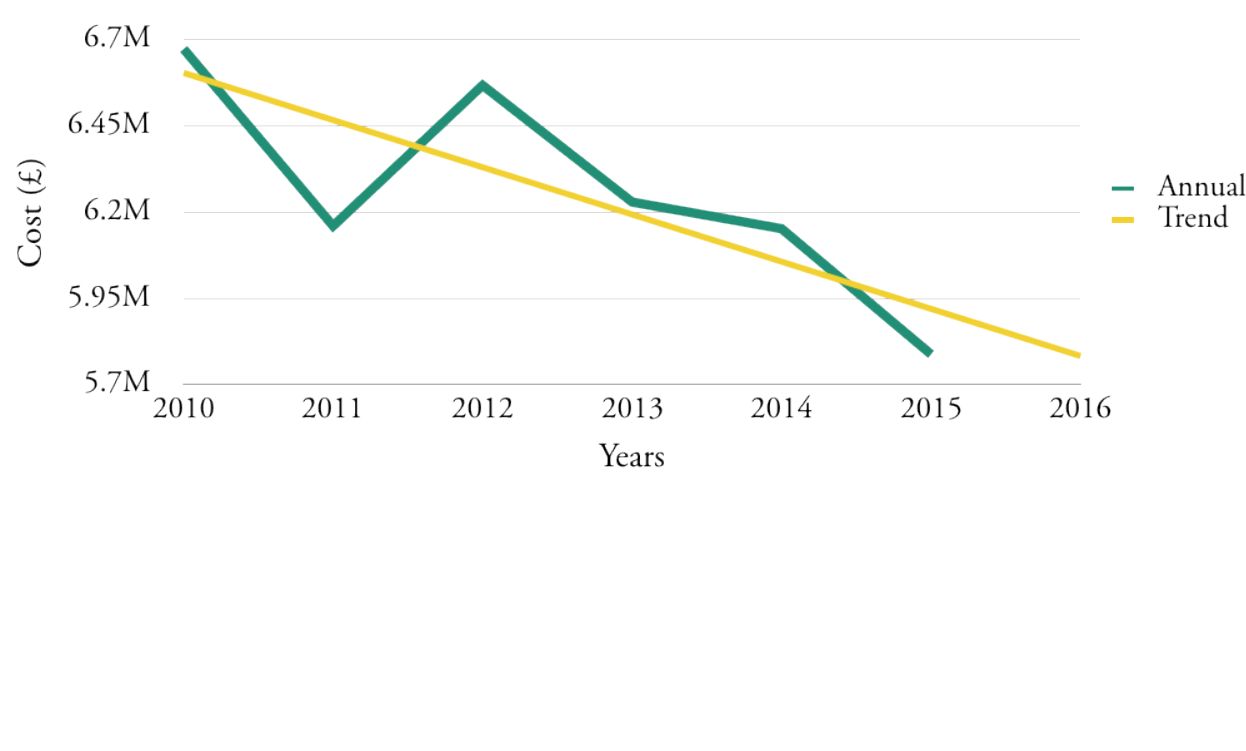
Figure 6: Annual cost of top twenty elements of six-year period.